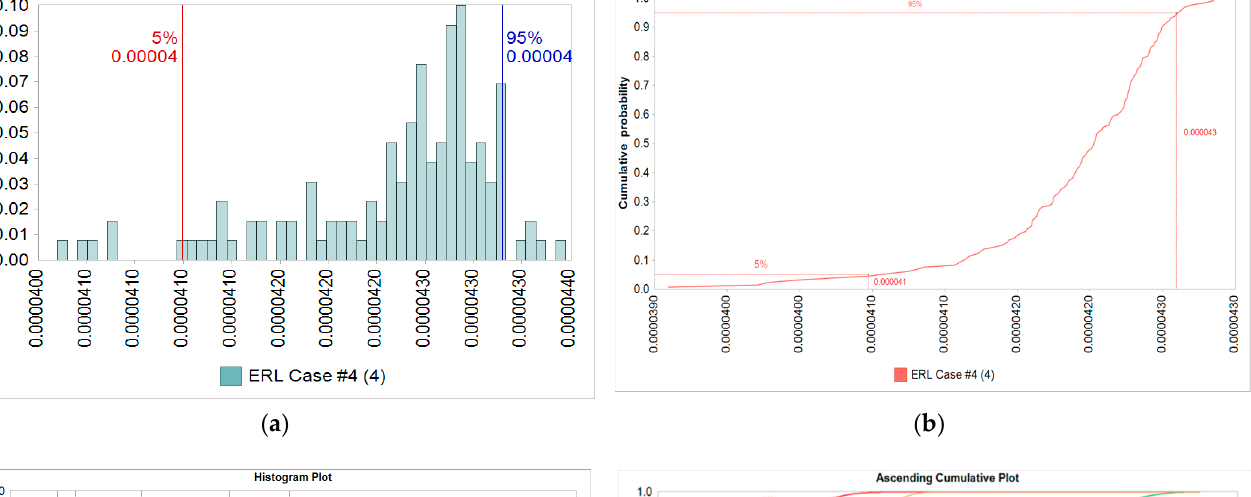
( b ) Figure 10. Case #4: Uncertainty analysis for ‘not complying with instructions’. ( a ) ERL uncertainty analysis for Case #4 with beta distribution. ( b ) ERL uncertainty analysis for Case #4 with triangular distribution. When considering the three main HOE variables and assuming a beta probability distribution, the result is shown in Figure 11a. The y-axis represents the probability and x-axis represents the ERL values. It can be noted that the outcomes of the simulations are concentrated on the right side of the histogram. The standard deviation is small at 5.40 × 10 − 7 with 5% and 95% uncertainty ranges from 4.15 × 10 − 5 to 4.30 × 10 − 5 . The cumulative probability distribution of the single-run curve (S-curve) for Case #4 is presented in Figure 11b where the mean ERL is 4.25 × 10 − 5 . Figure 11c shows the probability density plot and Figure 11d shows the cumulative probability distribution of the three HOE input variables that have a major impact on the final ERL for Case #4. The cumulative probability plot in Figure 11d indicates that the